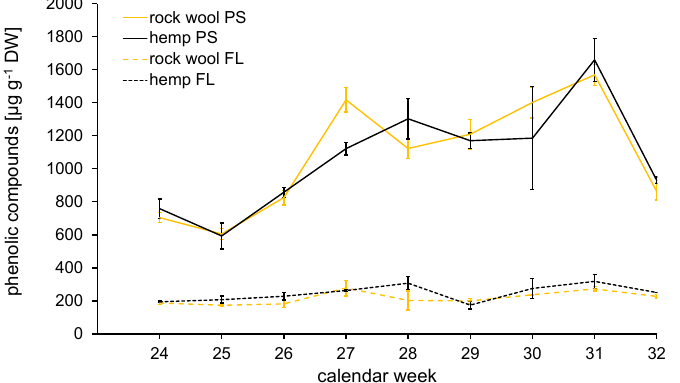
Figure 3. Mean total phenolic acid and flavonoid content in tomato fruit. No significant differences were found ( t ‐ test, p < 0.05, n = 3 over 9 harvest dates 3 weeks apart).